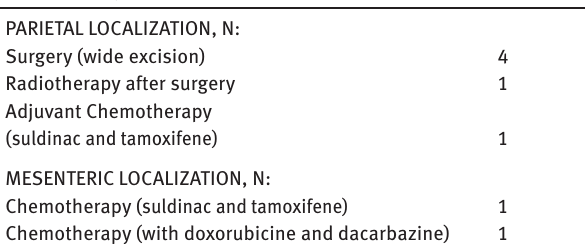
Table 1: Demographic and clinical presentation of the 5 patients with FAP and desmoid tumor